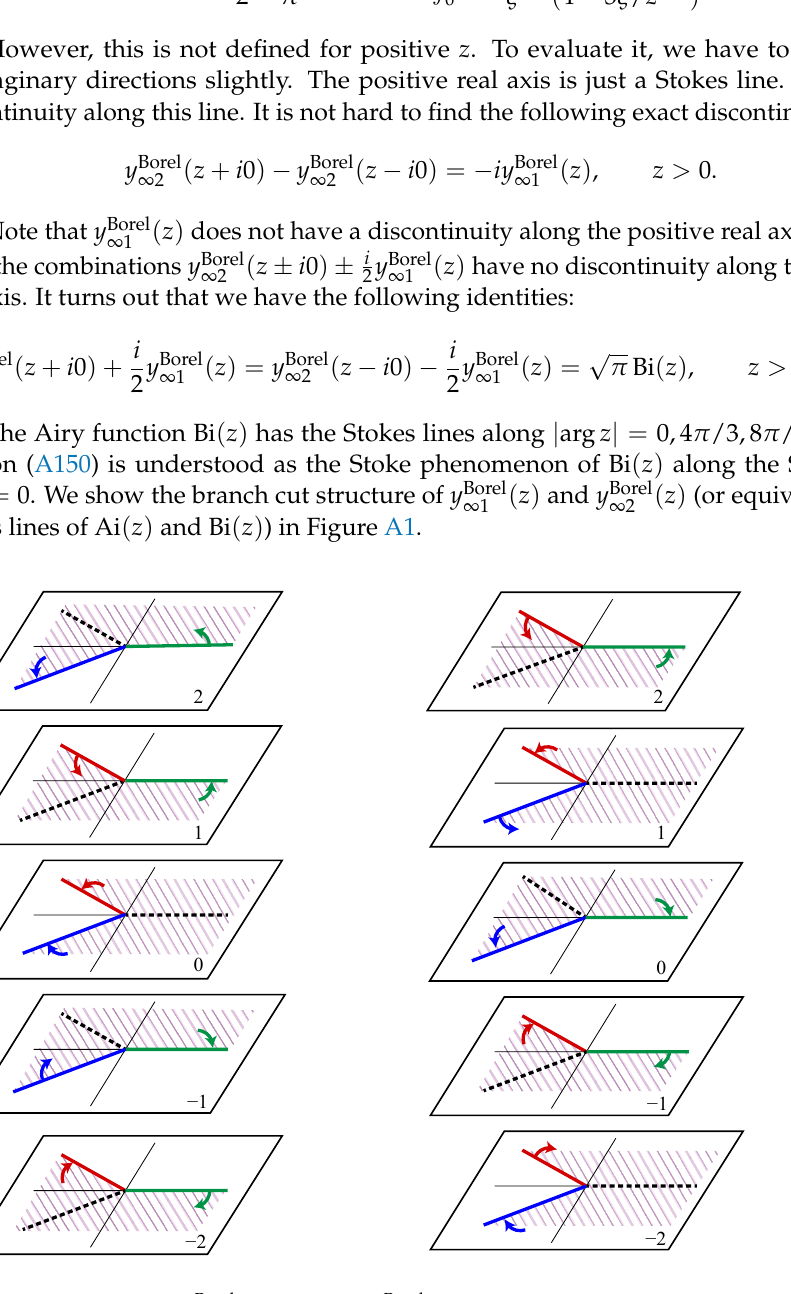
( z ) ( Right ) in the Airy equation. These correspond ( z ) ( Left ) and y Borel ∞ Figure A1. Branch cuts of y Borel ∞ 2 1 to the Stokes lines of Ai ( z ) and Bi ( z ) respectively. We start with the sheet 0, and cross the cuts in two opposite ways. The colored shaded domains are the Stokes sectors, and the dashed lines represent virtual cuts on other